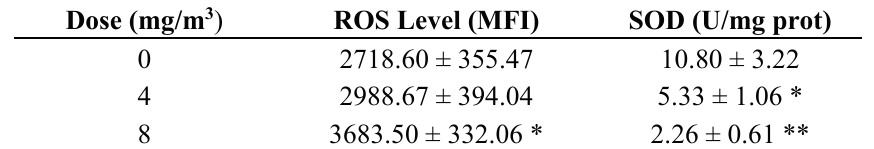
Table 2. ROS level and SOD activity in spleen cells from FA exposed